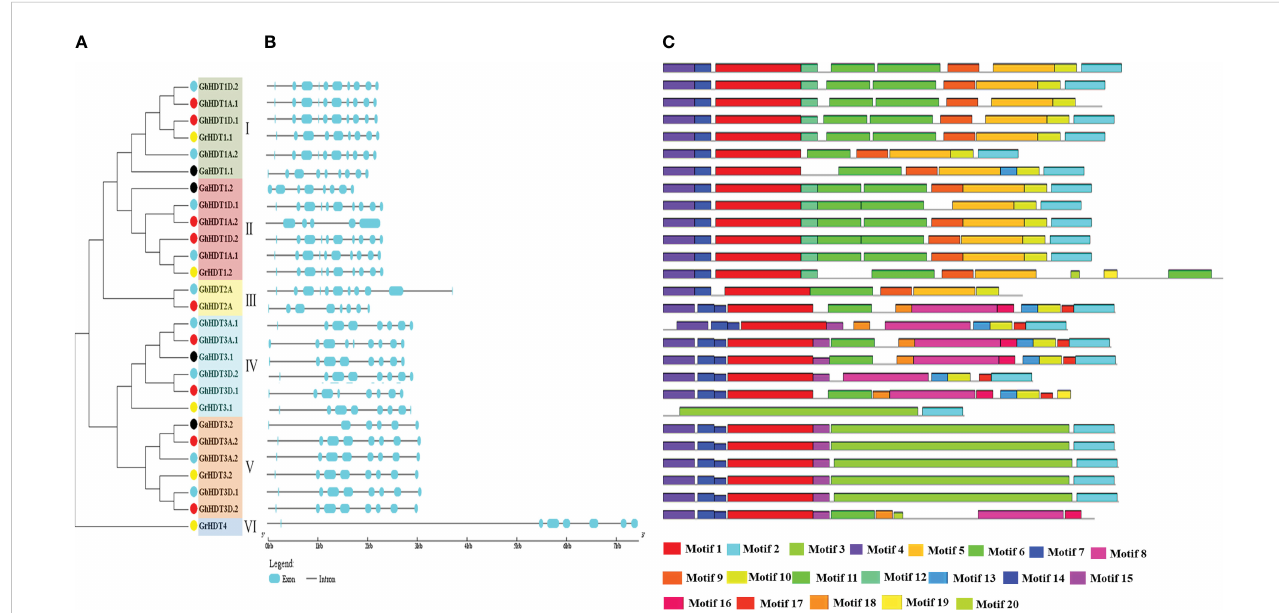
FIGURE 5 Phylogenetic tree, conserved protein motifs, and gene structure analysis of HD2 members found in G. arboreum, G. raimondii, G. barbadense, and G. hirsutum . (A) Phylogenetic tree of G. arboreum, G. raimondii, G. hirsutum, and G. barbadense constructed via the ML method using 1000 bootstrap values. Different dot colors represent different Gossypium species (black: G. arborium ; yellow: G. raimondii ; red: G. hirsutum ; sky blue: G. barbadense . Sub-families I, II, III, IV, V, and VI are shown in green, red, yellow, sky blue, and orange, respectively. (B) Representation of the gene structure of cotton HD2 members. Cyan boxes and black lines represent exons and introns, respectively. (C) Conserved protein motifs of HD2s, as determined using the MEME tool. Each motif is denoted by a speci fi c